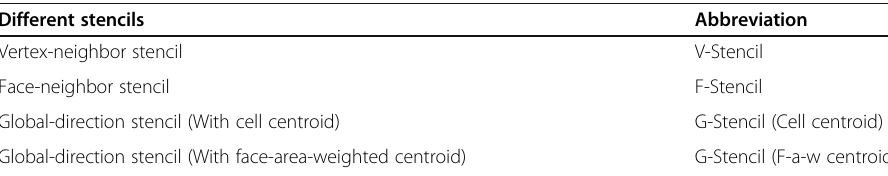
Table 1 Abbreviation of different stencils Different